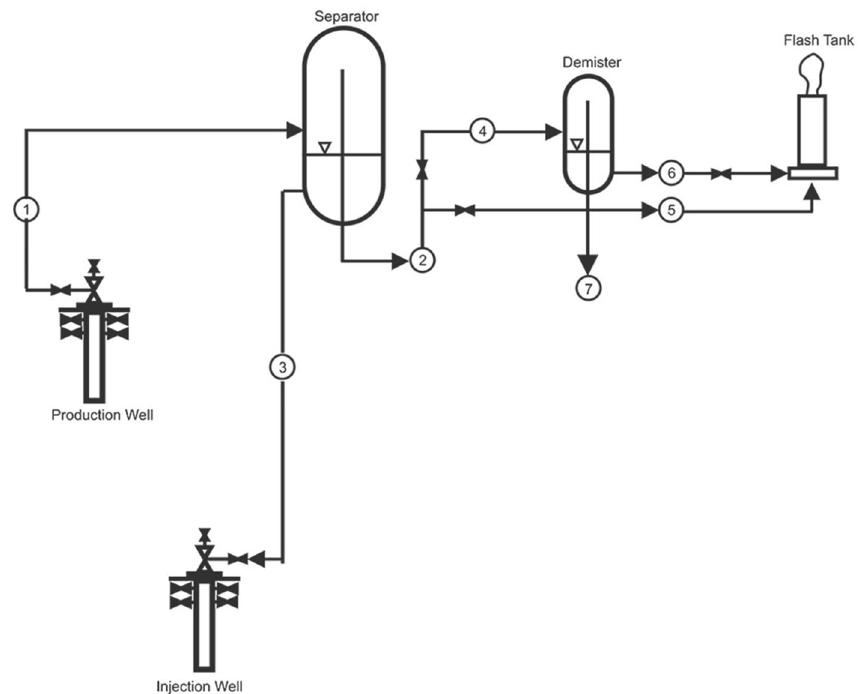
Fig. 3 Temperature–entropy (h–S) diagram for a single-flash power plant. Saturated water (h 3 ) and saturated steam (h 4 ) are created inside the separator. While brine, a liquid with a high enthalpy (h 3 ), is supplied to the reinjection wells, steam with a high enthalpy (h 4 ) is sent to the turbine (redrawn from DiPippo